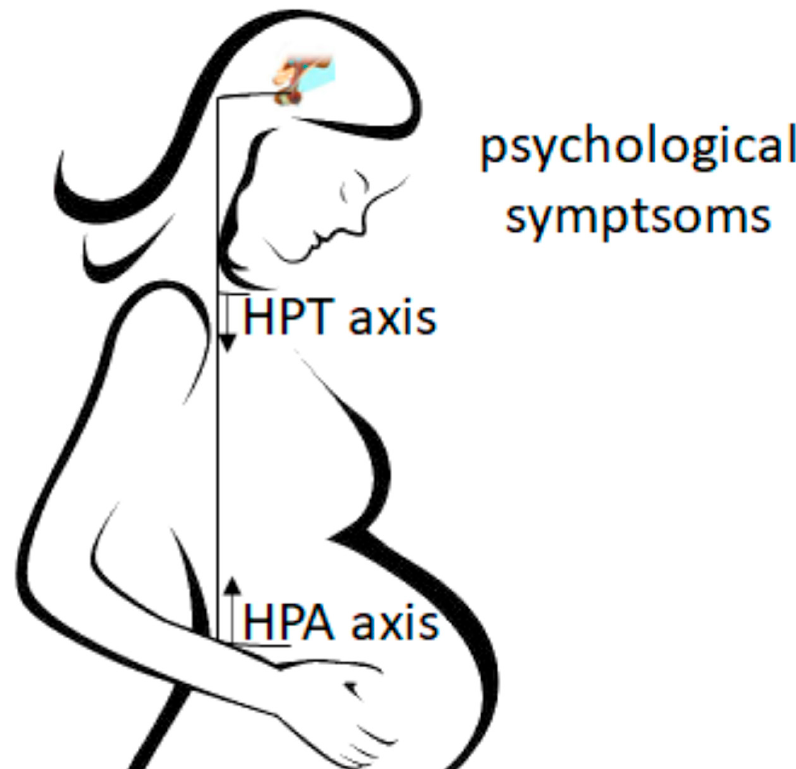
Figure 3. Hypothesis of the involvement of the hypothalamic–pituitary–adrenal axis (HPA) and the hypothalamic–pituitary–thyroid axis (HPT) in the mental health of pregnant women during the COVID-19 pandemic. The viral infection is responsible for the release of proinflammatory cytokines that cross the blood–brain barrier and activate the neuroendocrine system, especially HPA. Moreover, HPA is activated by stress and HPT is inhibited by stress. The deregulation of both HPA and HPT affects mental health with consequent psychological symptoms.